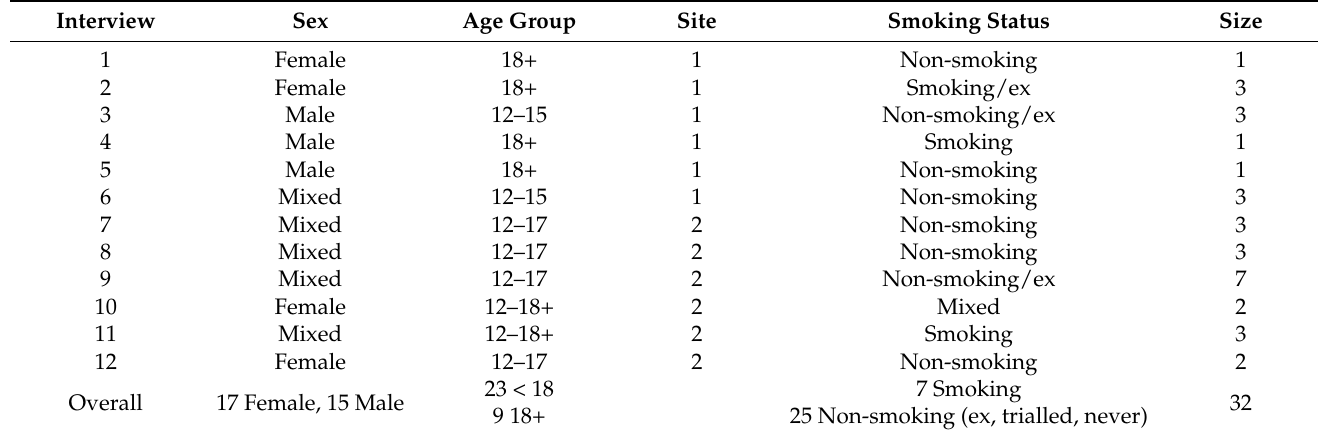
Table 1. Sample characteristics by yarning session.